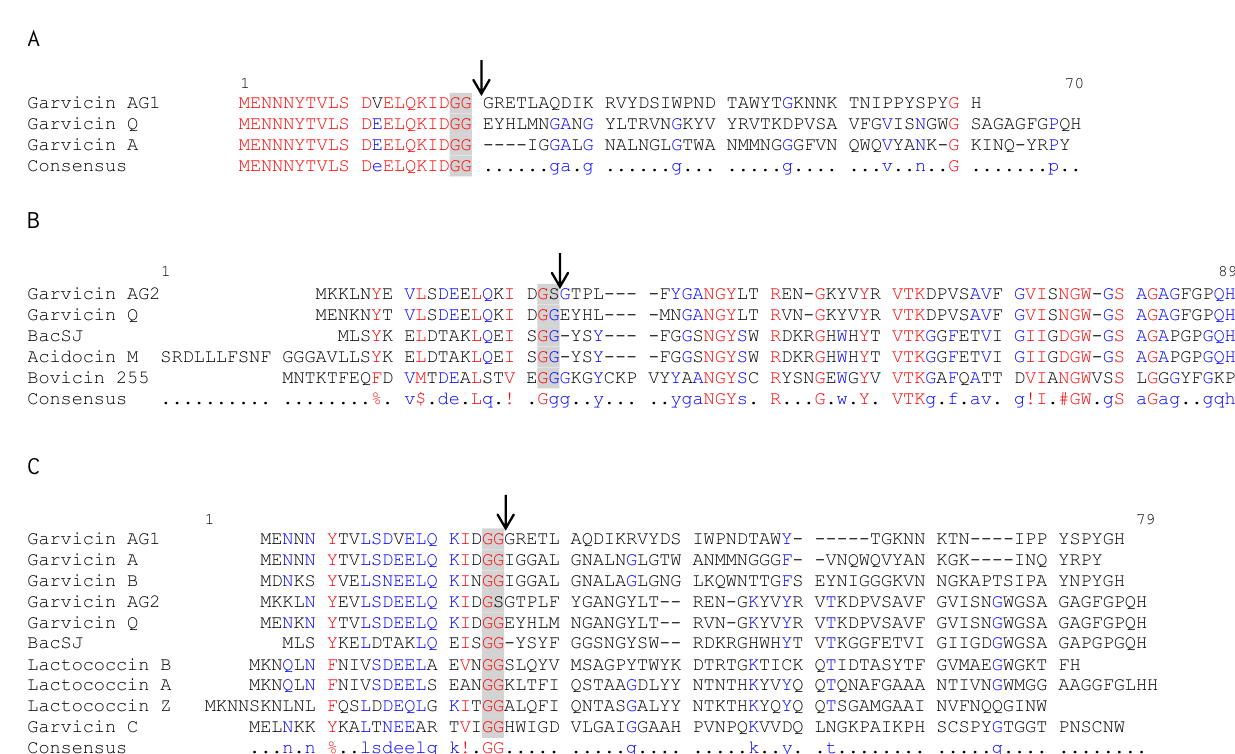
Figure 1. Alignment of the amino acid sequences of garvicin AG1 ( A ) and garvicin AG2 ( B ) precursor peptides with their known homologs and with class IId bacteriocins that use a mannose-specific phosphotransferase system (Man-PTS) as a receptor ( C ). The double-glycine motifs (GG or GS) of the leader peptides are highlighted with a grey background, and the black arrow indicates the cleavage site that generates the mature peptide bacteriocins. The sequences were aligned using the Multalin interface page (http://multalin.toulouse.inra.fr/multalin/). Highly conserved residues (consensus level = 90%) are indicated in red, whereas weakly conserved residues (consensus level = 50%) are indicated in blue. Consensus symbols are: !, I or V; $, L or M; %, F or Y; #, N, D, Q, E, B or Z.